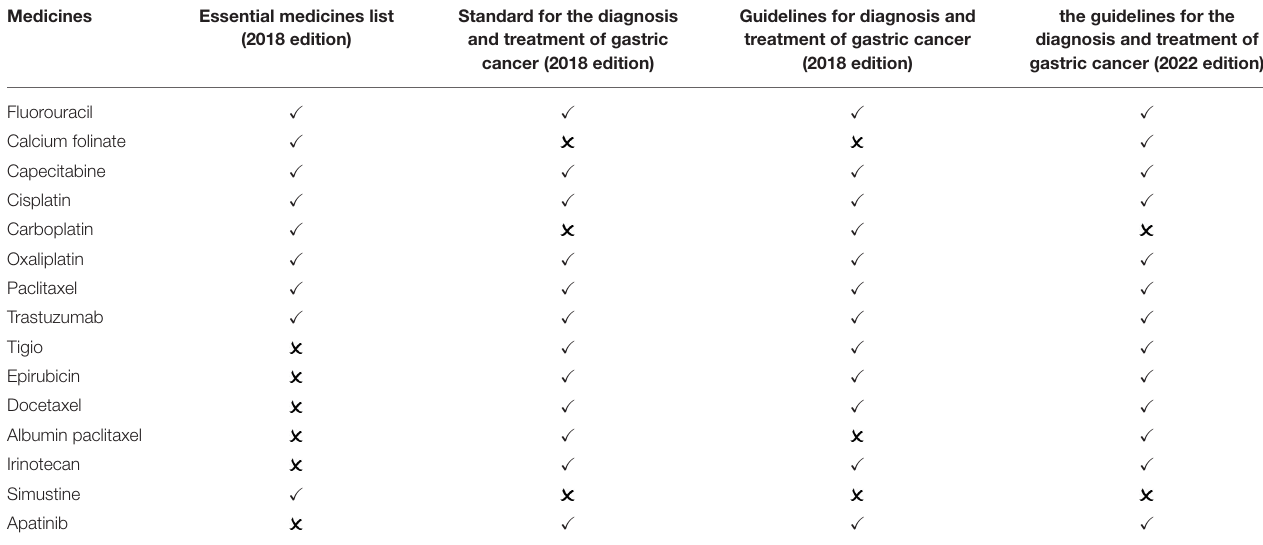
TABLE 6 | Medicines in the list and guidelines for the treatment of gastric cancer.